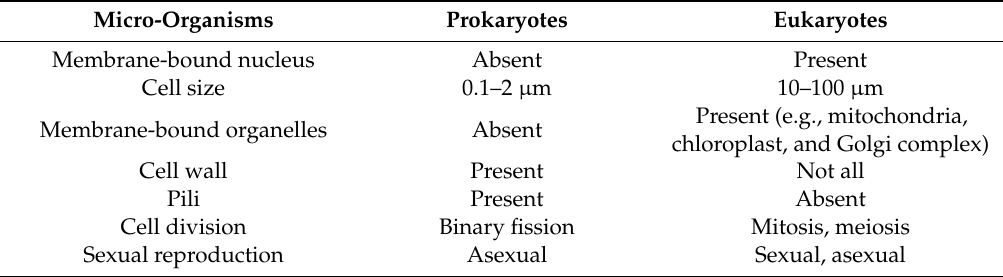
Table 3. Comparison between Prokaryotic and Eukaryotic Microorganisms [58].